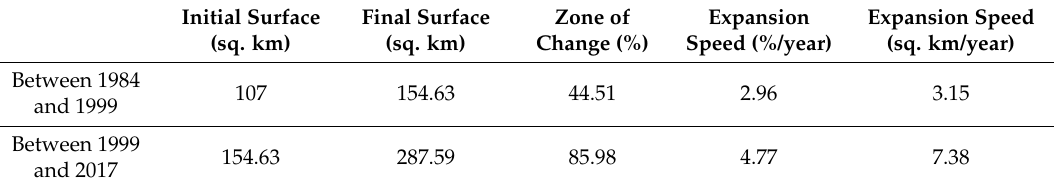
Table 1. Urban expansion statistics of